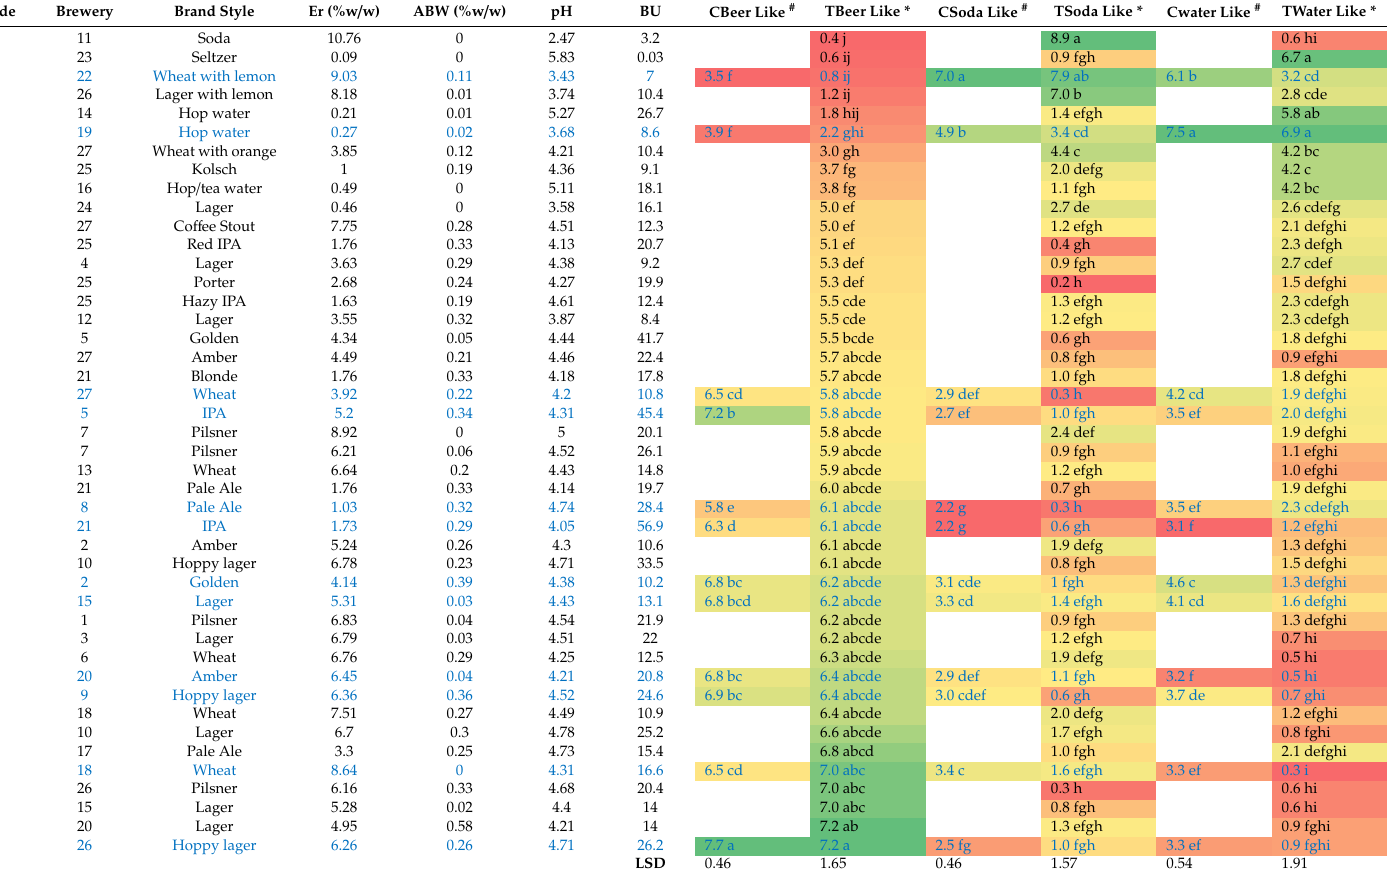
# Least square means based on the results of the consumer panel on 12 samples evaluated during consumer analysis (in blue). * Least square means based on the results of the trained panel on only the 44 samples evaluated during trained panel analysis. The columns are sorted by the trained beer likeness ratings and colored low to high similarity. Letters represent significant groupings based on Fisher’s least significant di ff erence (LSD) test at p < 0.05. The ratings for the panels were as follows; 1. extremely dissimilar, 2. very dissimilar, 3. moderately dissimilar, 4. slightly dissimilar, 5. neither similar nor dissimilar, 6. slightly similar, 7. moderately similar, 8. very similar, and 9. extremely similar. Abbreviations: real extract (Er), bitterness unit (BU), and alcohol by weight